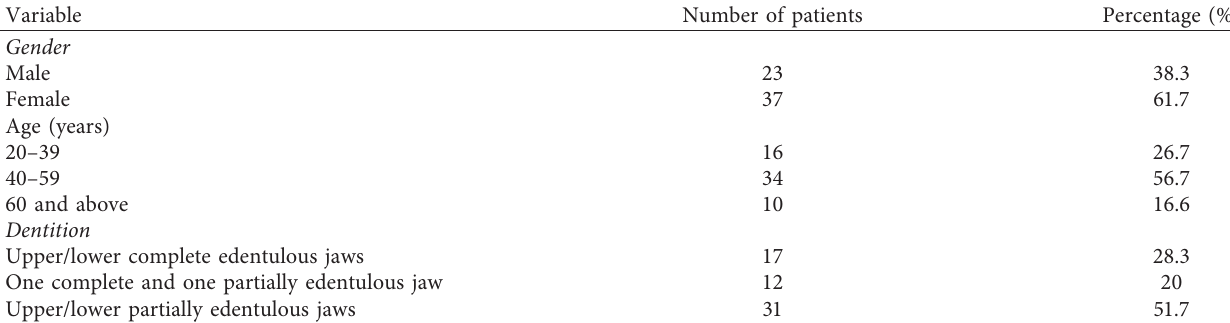
Table 1: Participants’ characteristics including patients gender, age, and dentition of the patients.